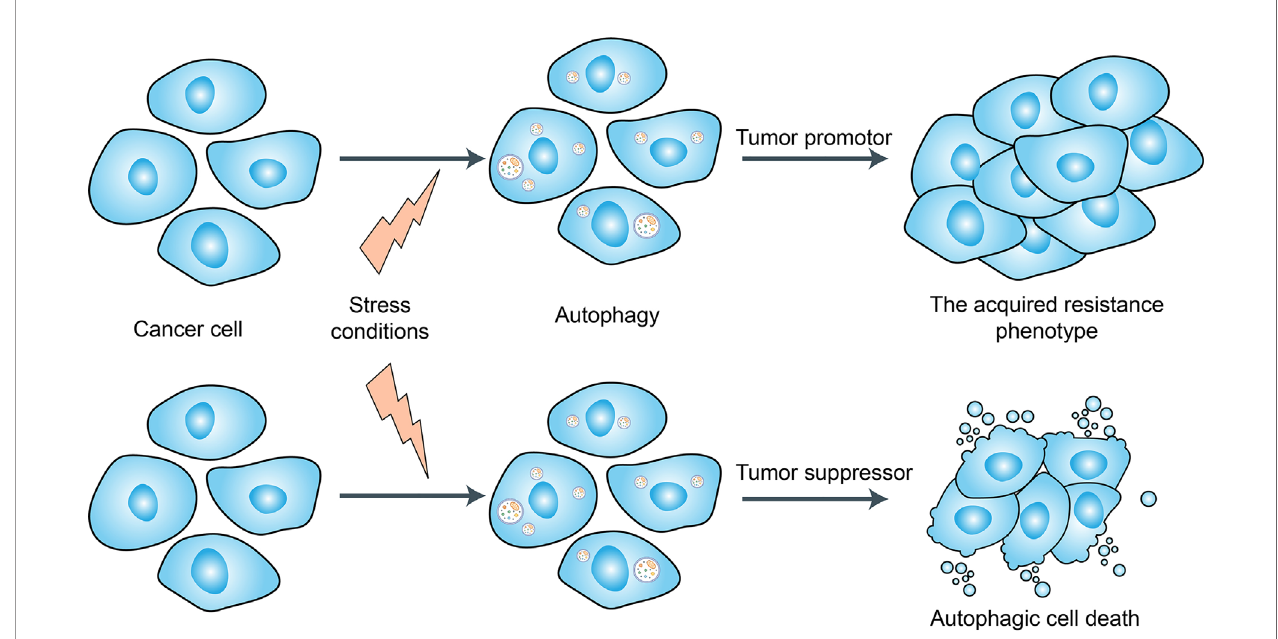
FIGURE 4 | Dual role of autophagy for therapeutic purposes in cancer. Autophagy is induced in tumors by many different stress conditions including some cancer therapeutic approaches, which function as a death executioner to induce autophagic cell death. But autophagy also provides resistance to cancer cells against chemo-/radio-therapies and cell